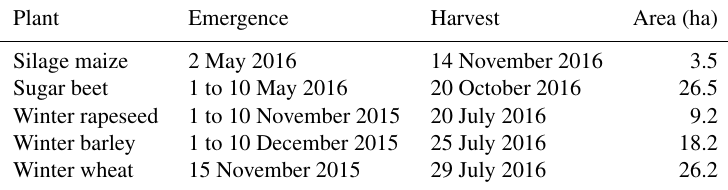
Table 1. Range of emergence and harvest dates and total area for the five crops cultivated in the study area in 2016.